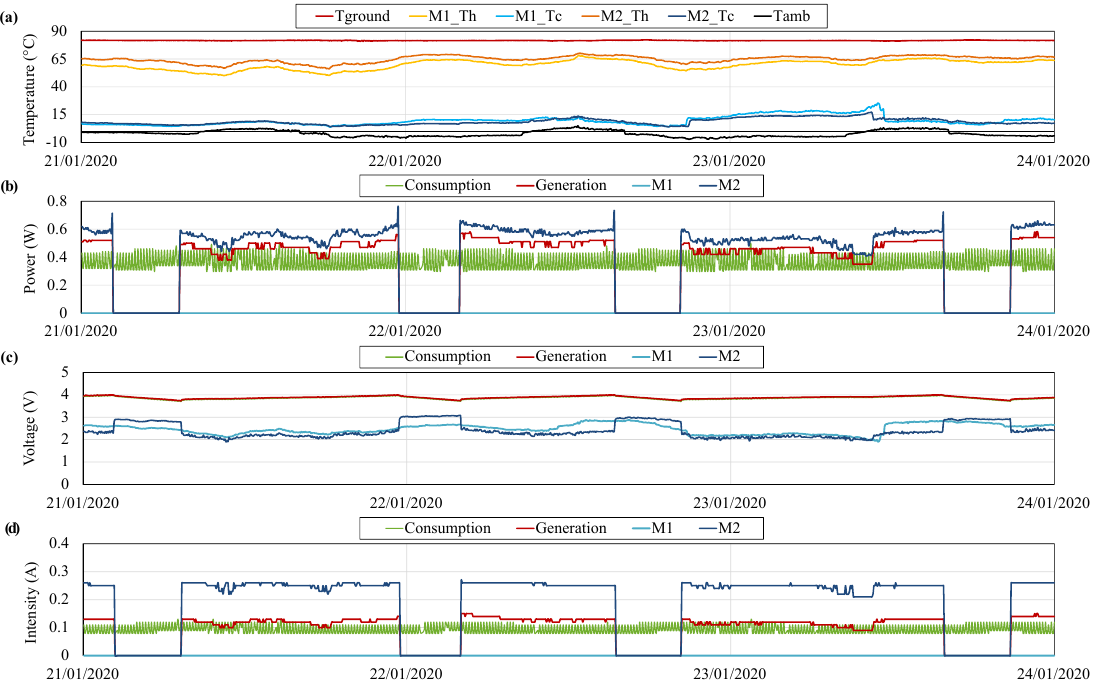
Figure 14. ( a ) Temperature, ( b ) power, ( c ) voltage and ( d ) intensity measurements during several cold